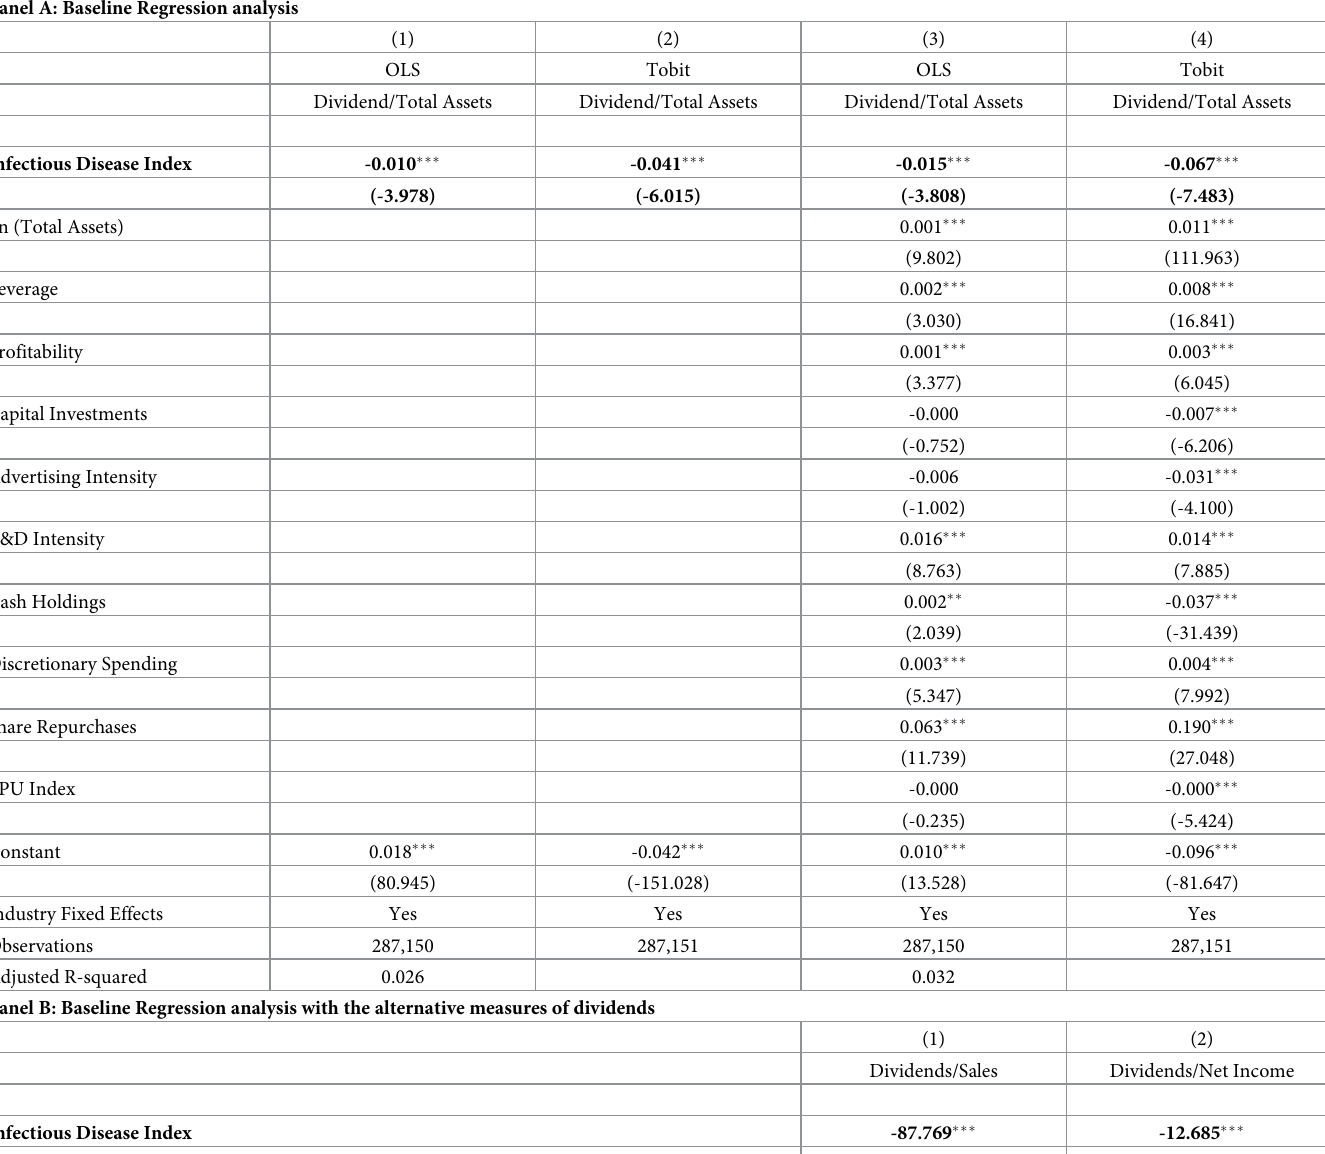
Table 2. The effect of infectious diseases on corporate dividend policy. Our measure of disease-related uncertainty is the infectious disease equity market volatility developed by Baker et al. (2020) [9]. Using sophisticated textual analysis, Baker et al. (2020) [9] search for news articles related to infectious diseases and equity market vola- tility. A higher fraction of these news articles to all articles in each time period signifies a higher level of market uncertainty that can be ascribed to infectious diseases. For ease of interpretation, we have the infectious disease equity market volatility index divided by 100. Panel A: Baseline Regression